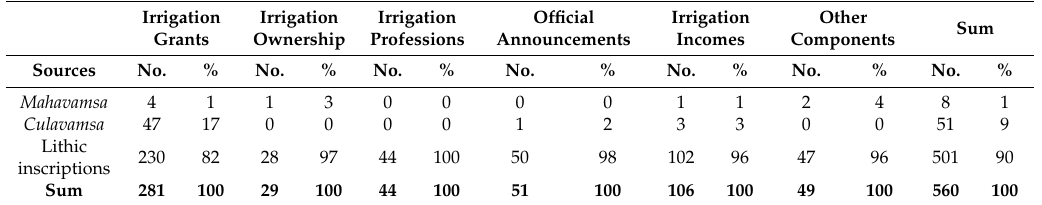
Table 1. Number of records of irrigation and percentages from different